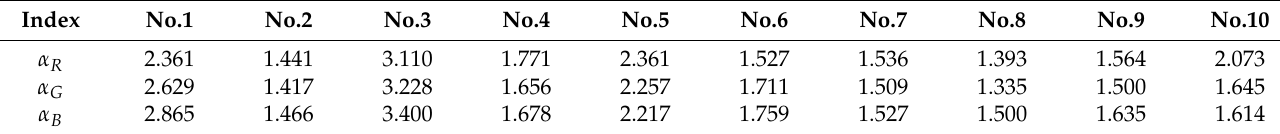
Table 2. Values of the color extension coefficient α c of the ten Gaussian